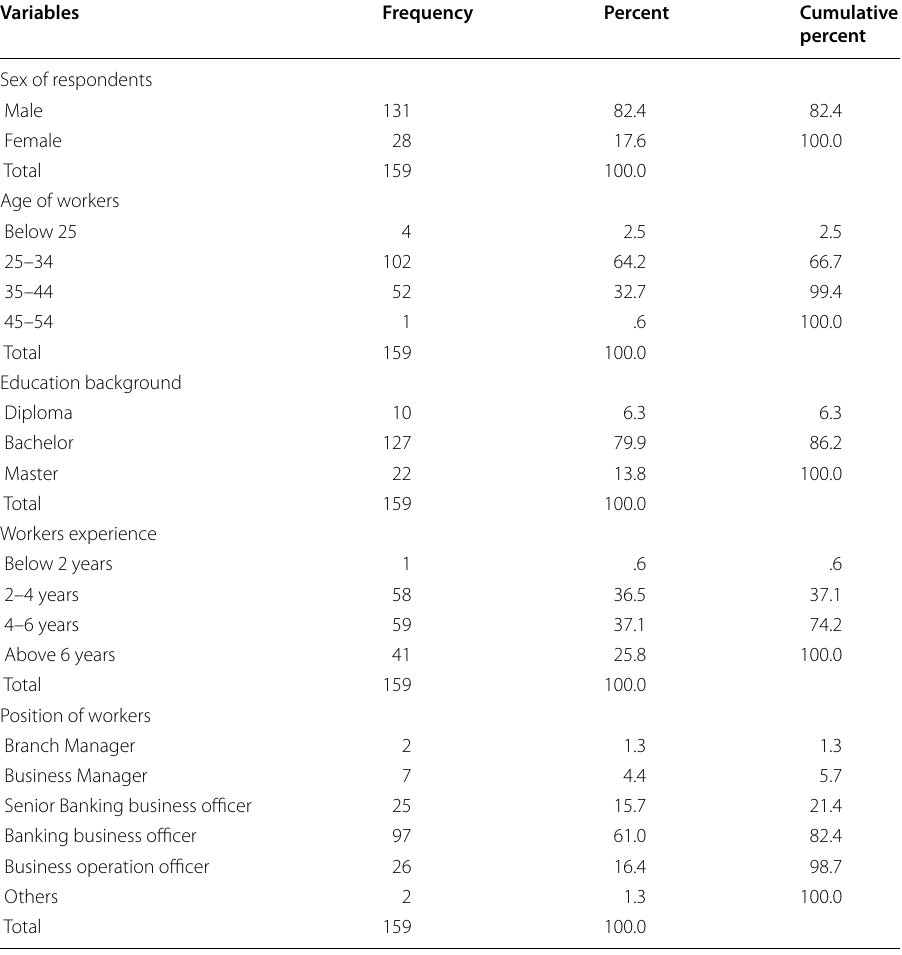
Table 3 Descriptive statistic of the demographic variables. Source: own survey (2020) Variables